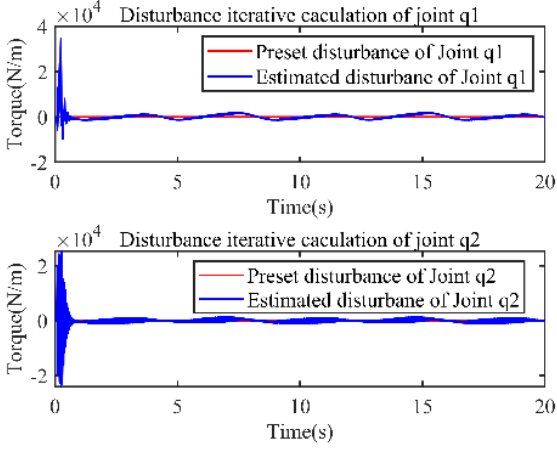
Figure 3. Disturbance observation.